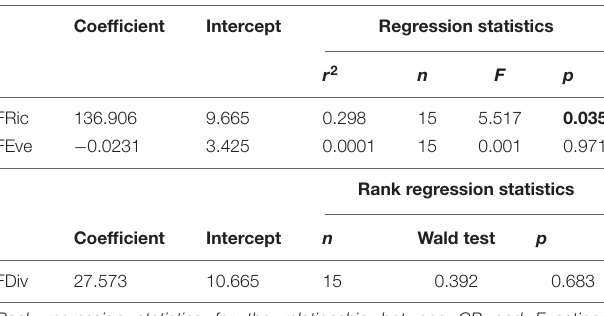
TABLE 2 | Linear regression statistics for the relationship between CP (mg DW d − 1 ) and functional diversity indices; Functional Richness (FRic) and Functional Evenness (FEve).